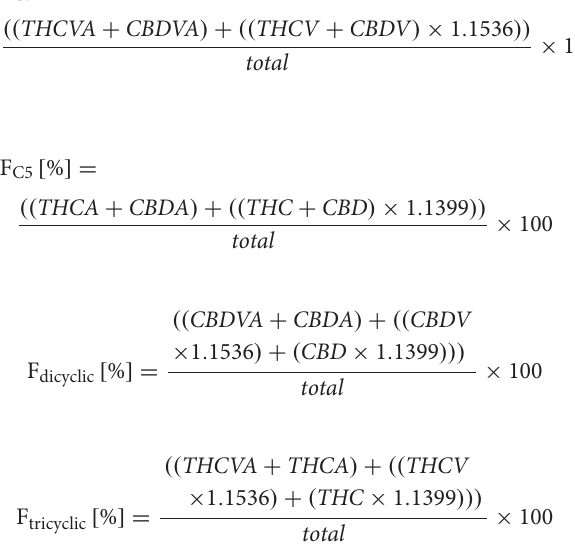
Frontiers in Plant Science |